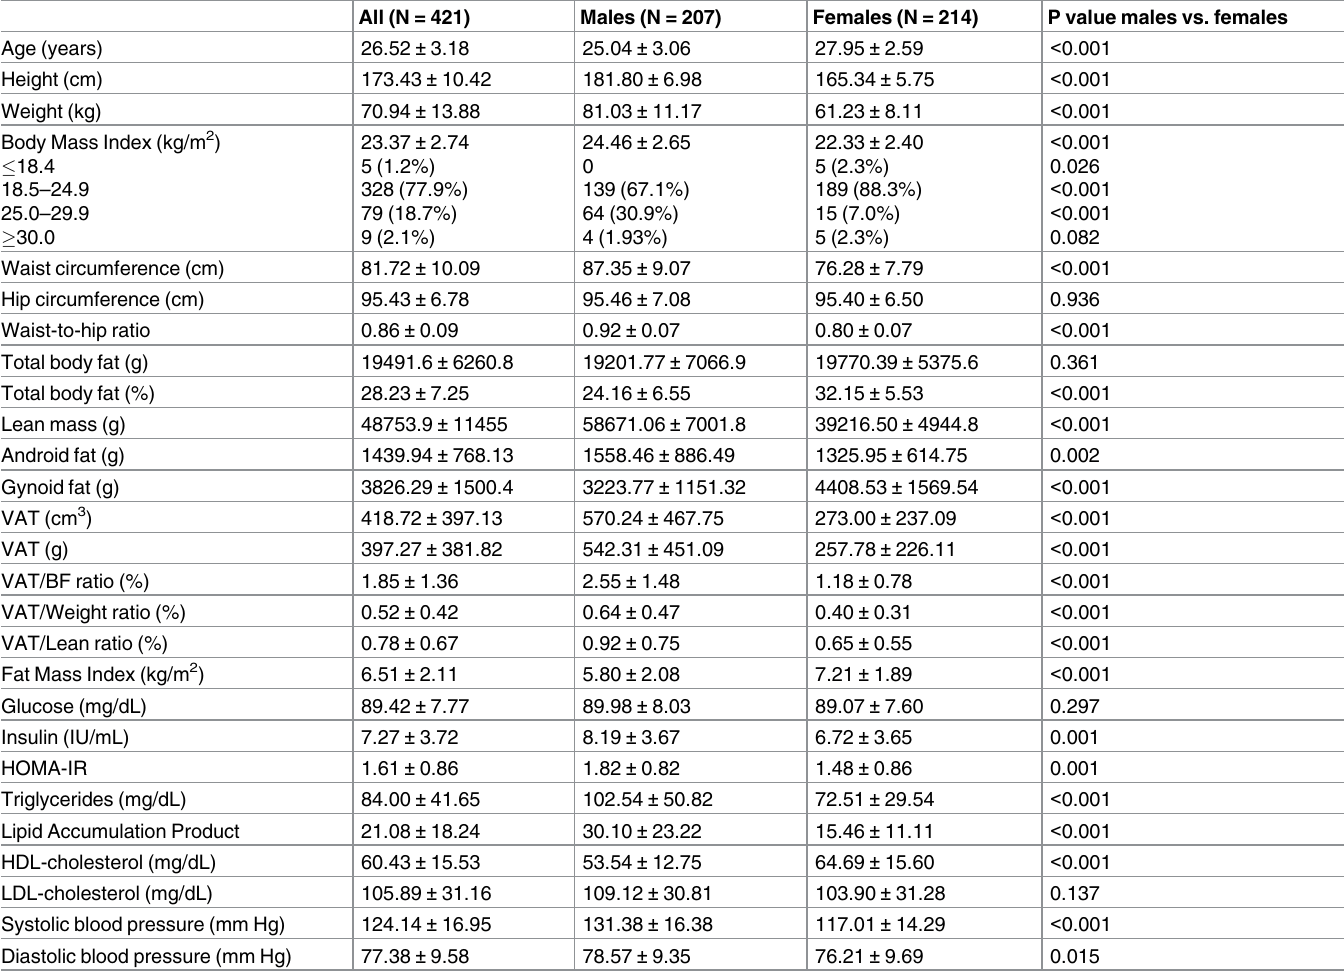
Table 1. Descriptivecharacteristics of participants by